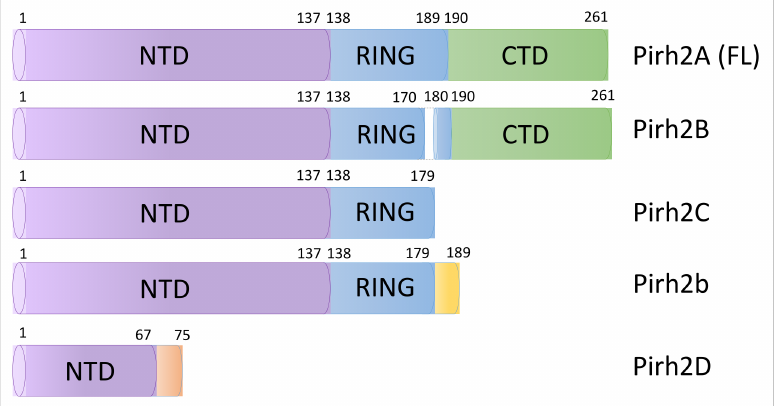
Figure 1. The schematic illustration of Pirh2 domain structure and its isoforms. FL—full-length isoform; NTD—amino-terminal domain; RING—RING domain; CTD—carboxy-terminal